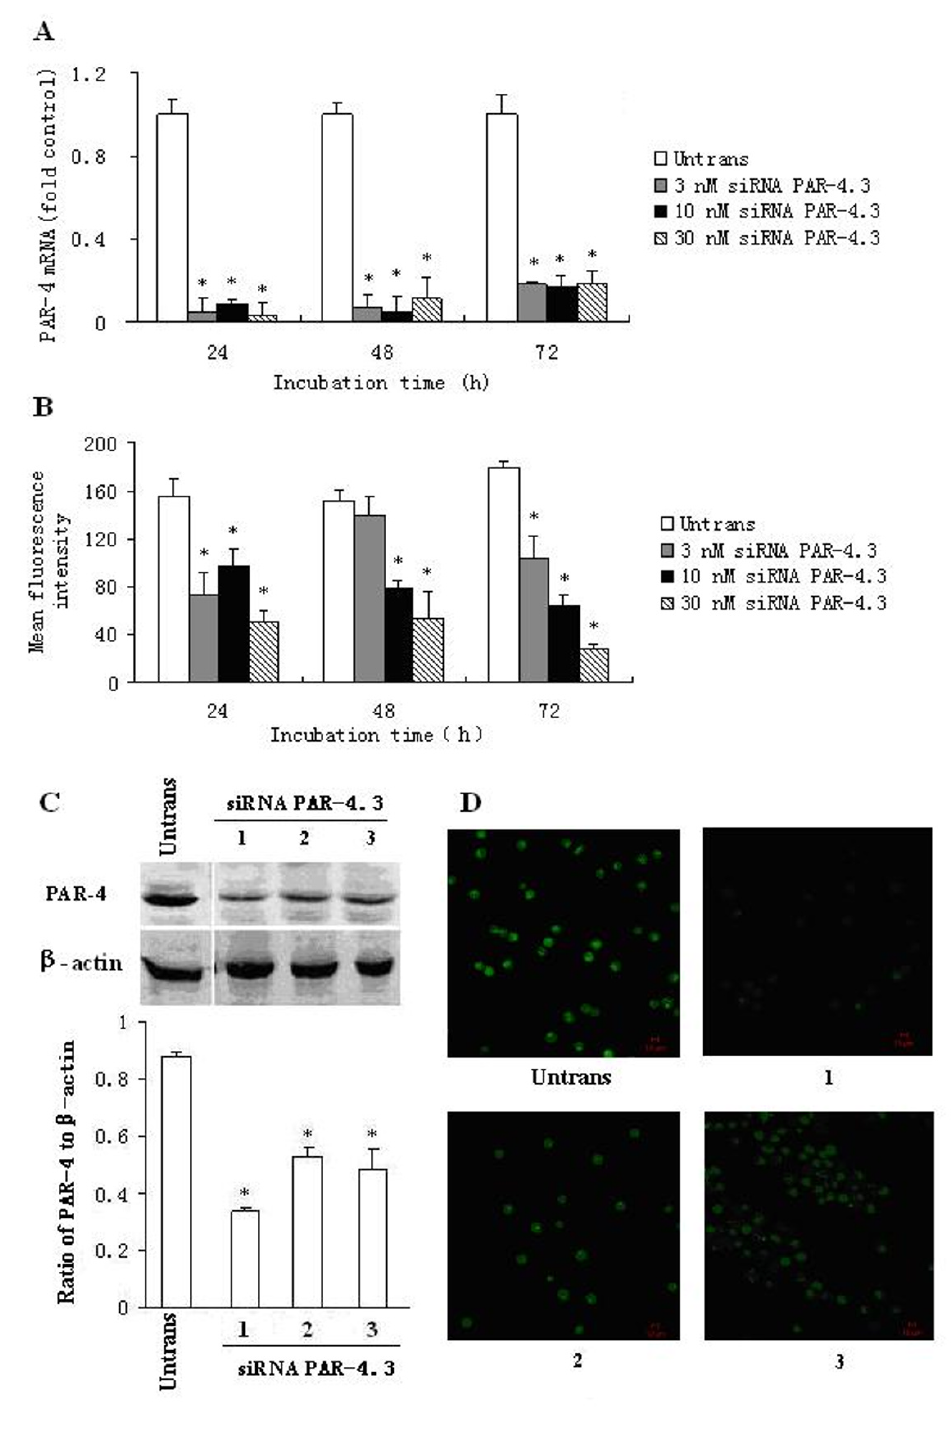
Figure 3 Effect of siRNA PAR-4.3 on PAR-4 expression in P815 cells . P815 cells were transfected with siRNA PAR-4.3 for 24, 48 and 72 h. The PAR-4 expression was determined by real-time quantitative PCR (A), flow cytometry (B), Western blot (C) and immunofluorescent analysis (D). In (C) and (D), 1 = 3 nM, 2 = 10 nM and 3 = 30 nM of siRNA PAR-4.3. Values shown are mean ± SEM for four to five independent experiments. * P < 0.05 compared with the untransfected